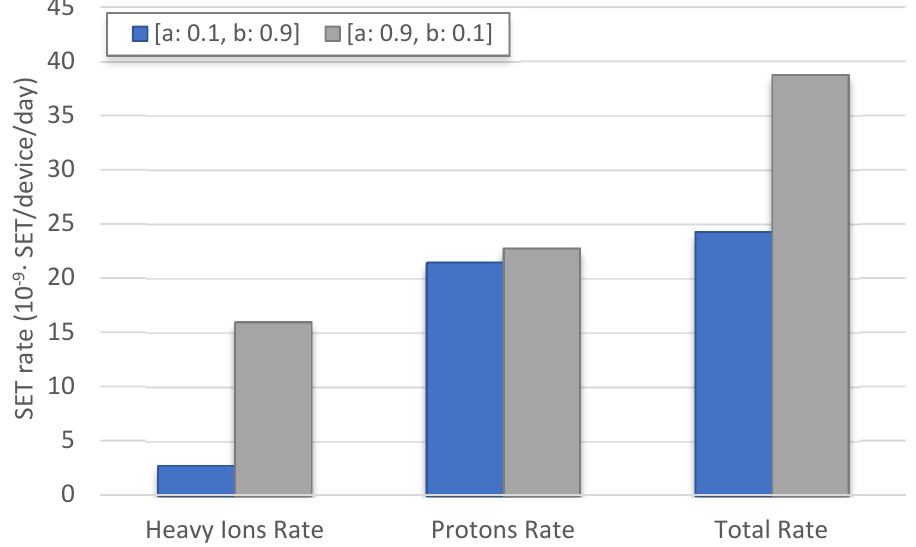
Figure 11. In-orbit SET rate calculated with OMERE [49] based on the proposed SET characterization considering a Geostationary Orbit (GEO), 35,784 km.